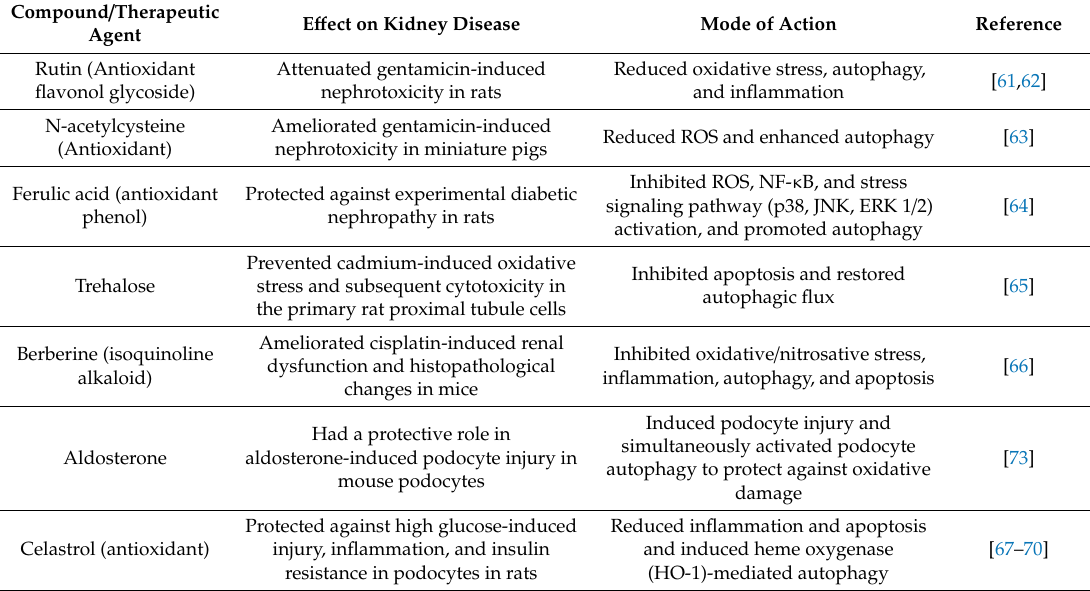
Table 1. E ff ect of antioxidant / drug on autophagy in kidney